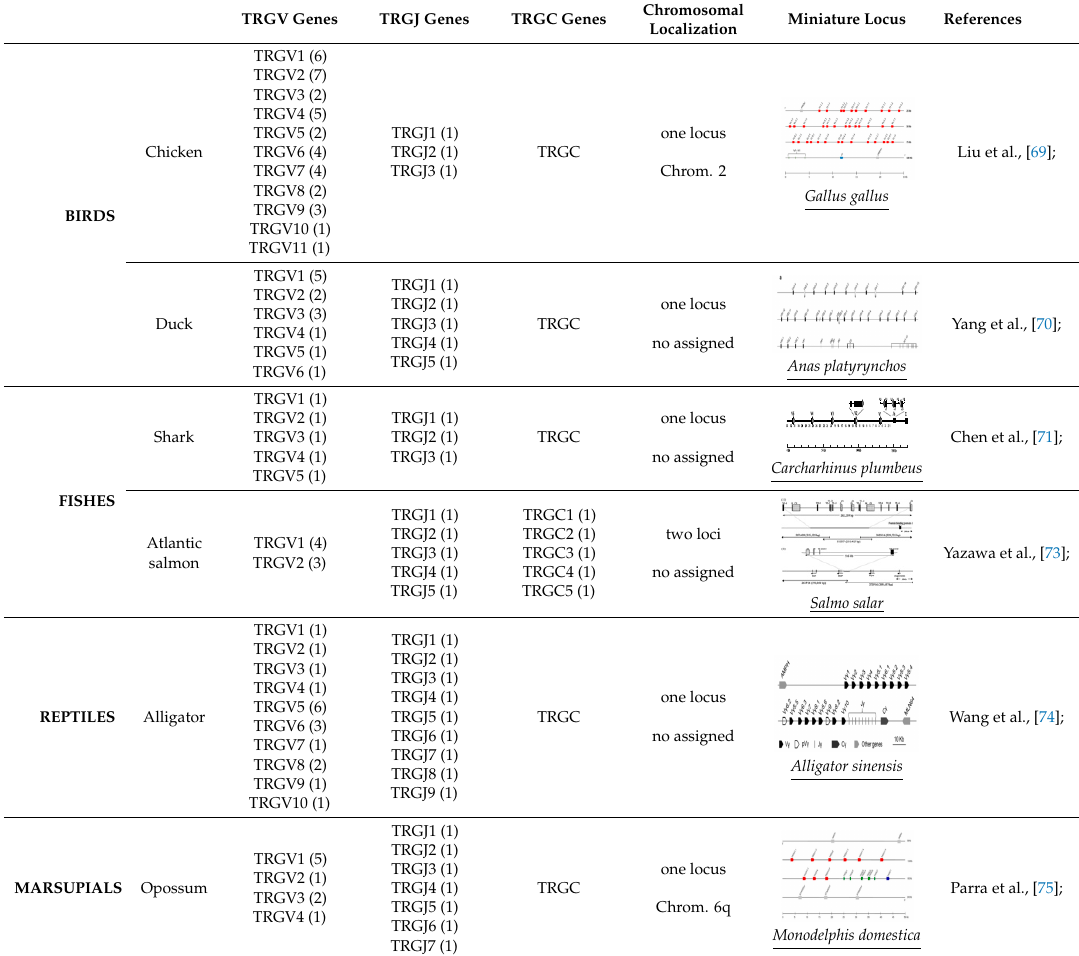
Table 1. Genomic organization and gene content of the TRG locus in the outgroups.